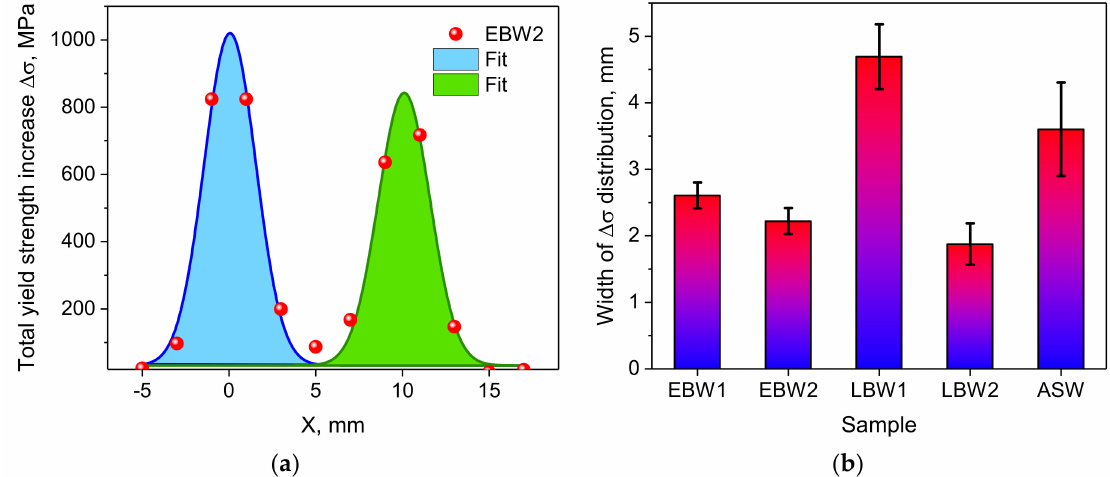
Figure 14. ( a ) Distribution of the total yield strength increase ∆ σ = ∆ σ ρ + ∆ σ HP for EBW2 specimen fitted with two Gaussians. ( b ) Estimated FWHMs of yield strength increase ∆ σ